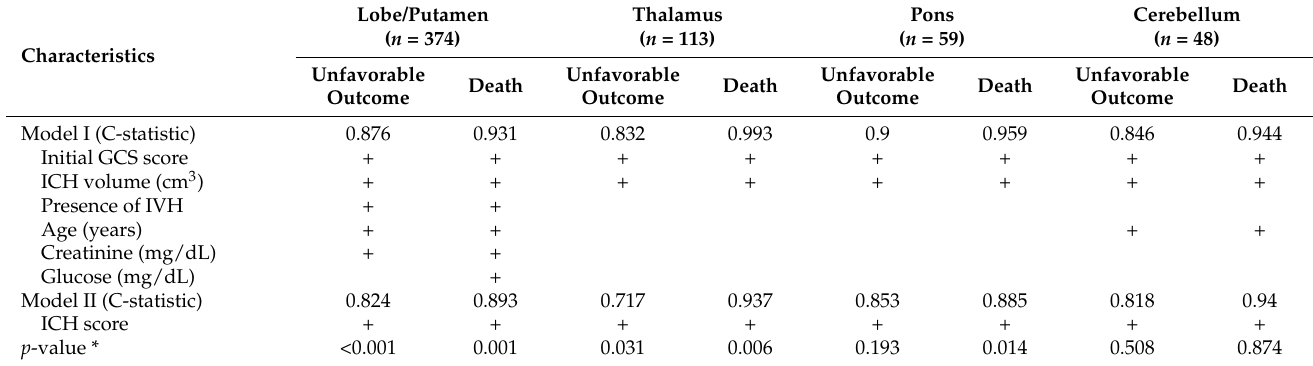
Table 5. C-statistics of predictors of unfavorable outcomes and death for intracerebral hemorrhage in different locations.